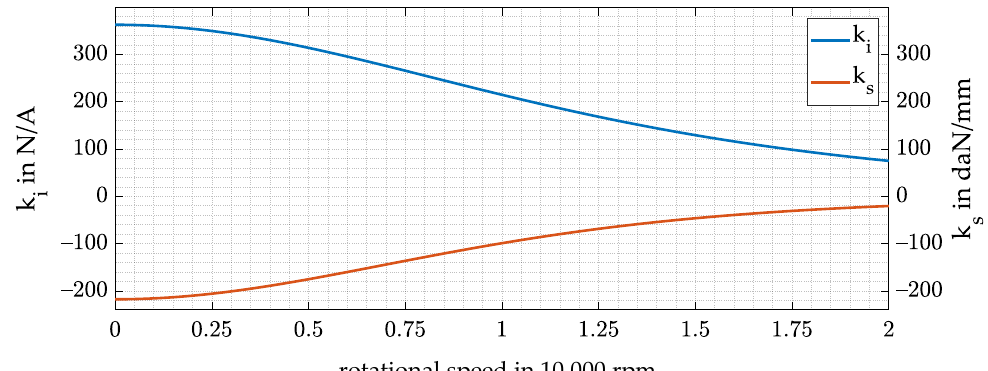
Figure 4. k i and k s against the rotational speed.